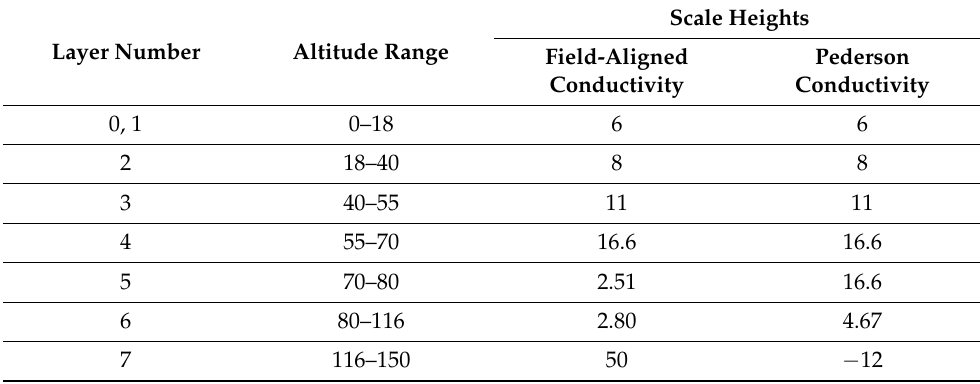
Table 1. Conductivity scale